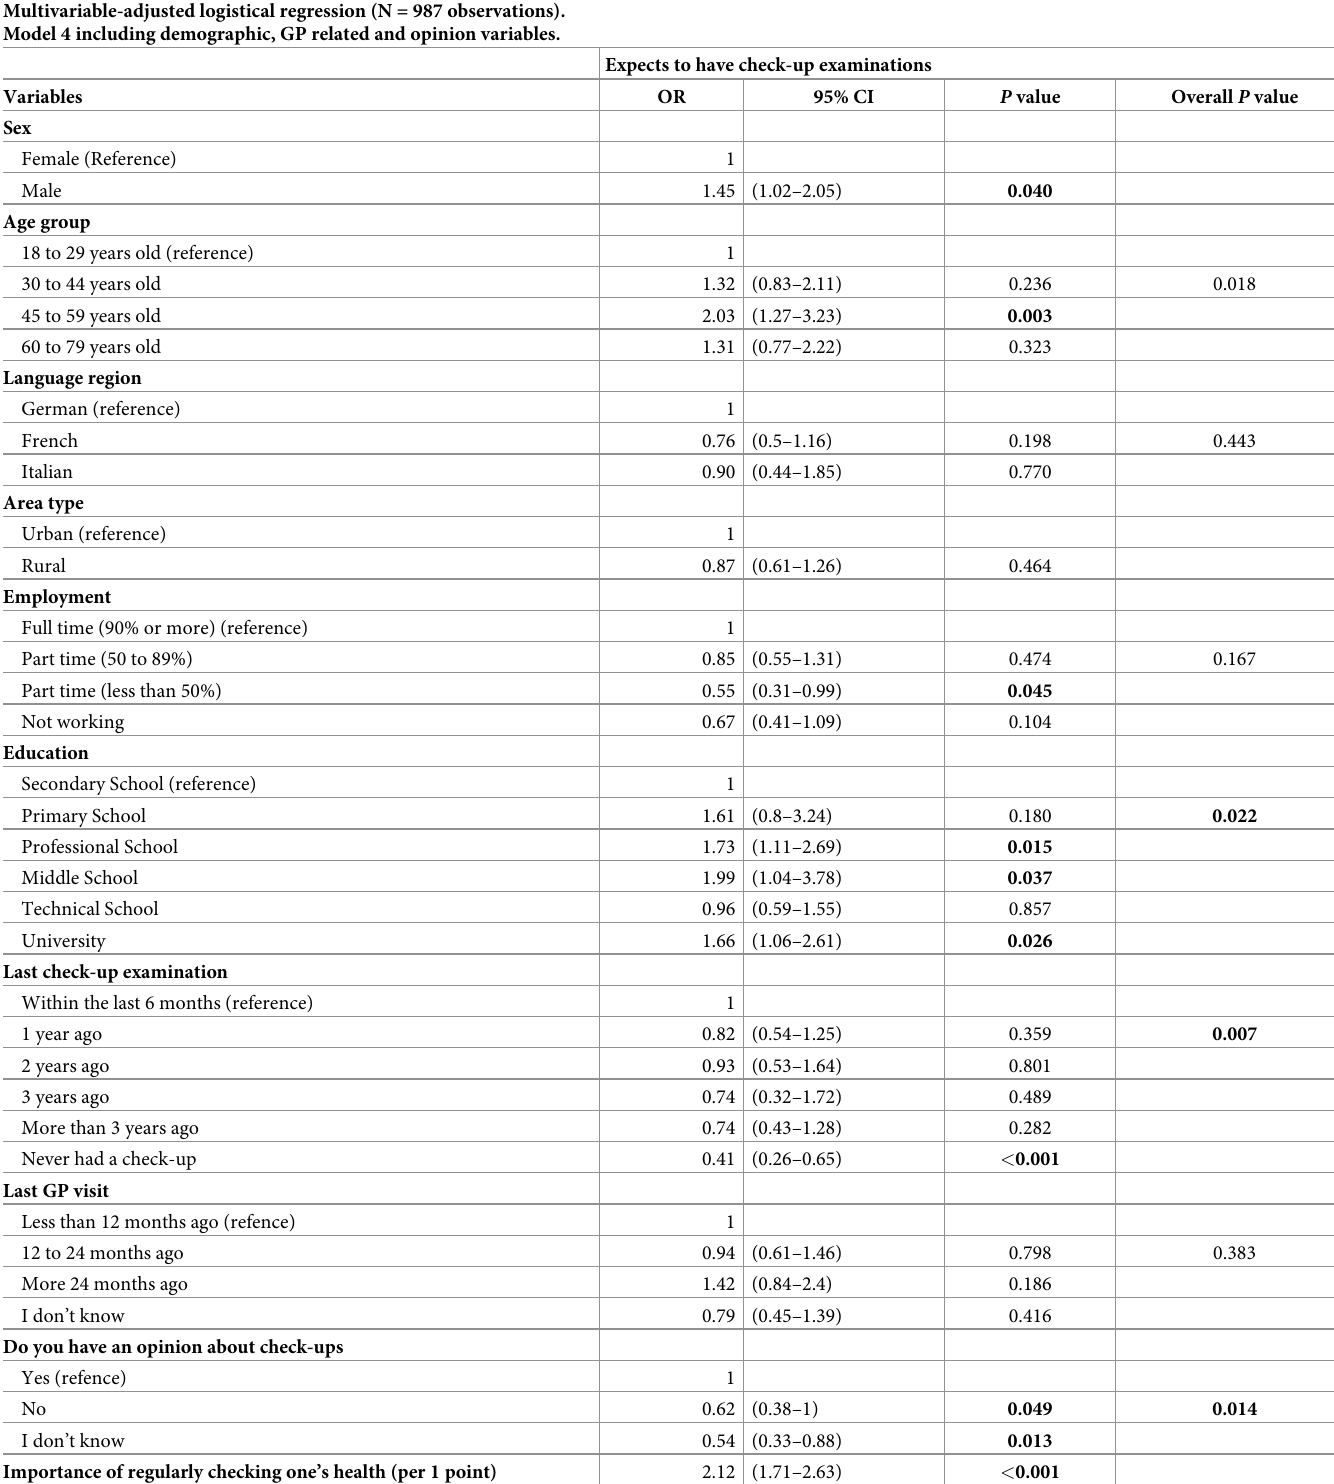
Table 4. Factors associated with check-up expectations. Factors associated with the expectation of having check-up examination. Multivariable-adjusted logistical regression (N = 987 observations). Model 4 including demographic, GP related and opinion